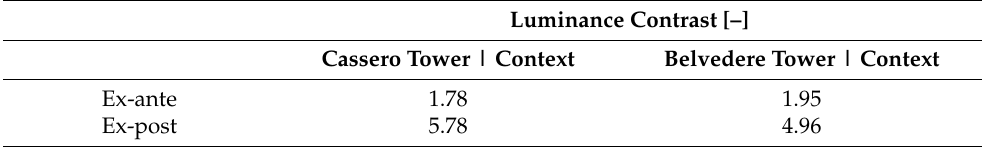
Table 18. Observation point E2. Luminance contrasts.